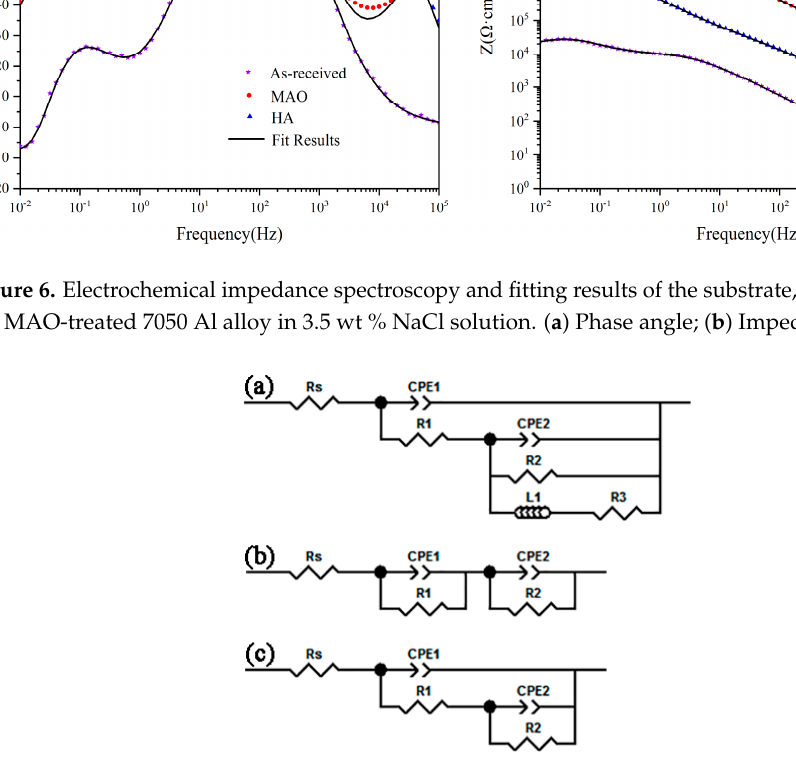
Figure 7. Corresponding equivalent circuits for fitting impedance date of the substrate ( a ); and the HA- ( b ); and, MAO- ( c ) treated 7050 Al alloy.